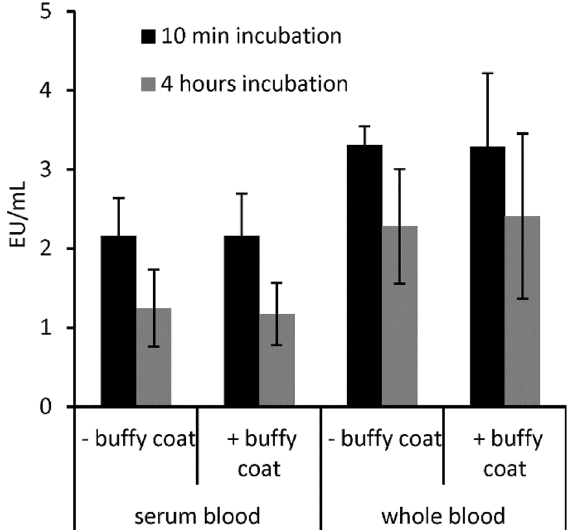
Figure 14. Influence of leucocytes on endotoxin activity in blood. It was examined whether the incubation of LPS with leucocytes has an influence on the endotoxin activity. This was performed with heparinized whole blood as well as with serum blood without anticoagulant. Blood with normal leucocyte count is labeled with “+ buffy coat”, leucocyte-depleted blood is labeled as “− buffy coat” in the graph. Mean ± standard deviation of three independent experiments with blood from different donors are